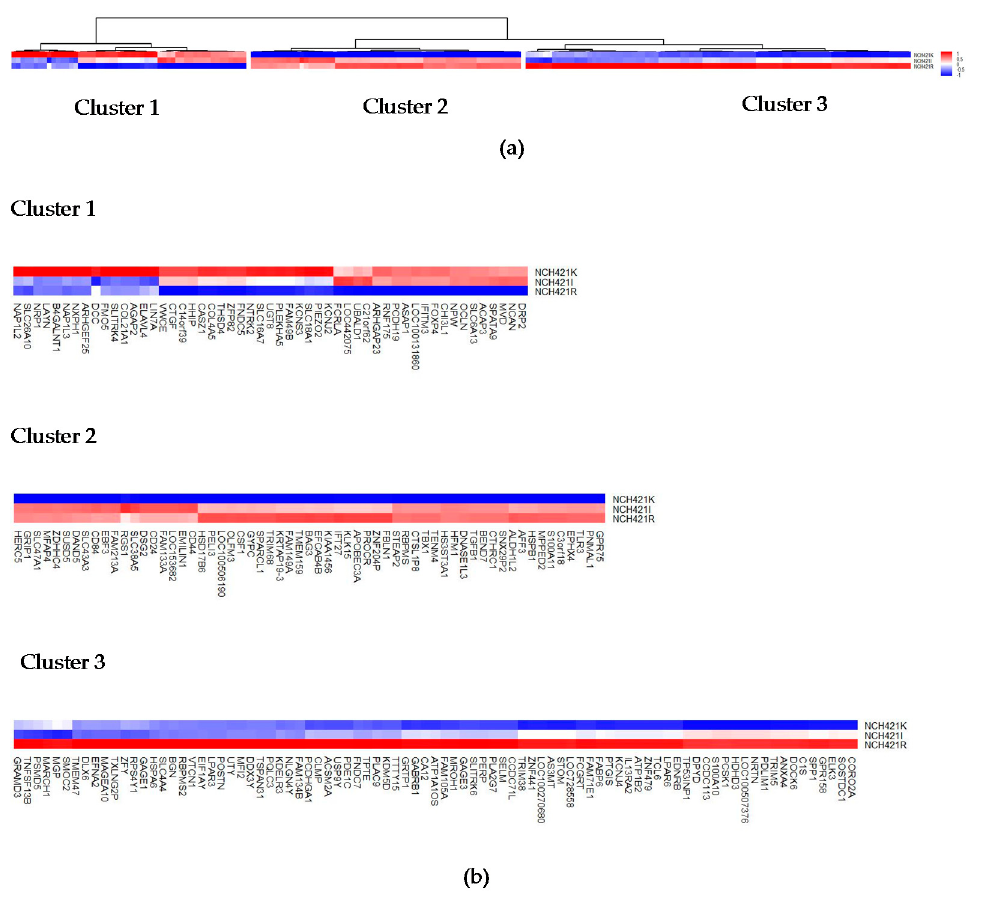
Figure 7. Comparative transcriptome analysis of the NCH421k and its partially and fully H-1PV resistant subclones NCH421I and NCH421R . ( a ) Unsupervised clustering of the 201 genes most differentially expressed between NCH421k, NCH421I and the resistant subclone NCH421R. Quantitative comparison of the three profiles reveals genes that are up ( red ) or down ( blue ) regulated in resistant NCH421R cells in comparison with NCH421I and NCH421k cells showing high susceptibility to H-1PV infection; ( b ) Each of the three main clusters is shown independently in order to allow a more detailed analysis.